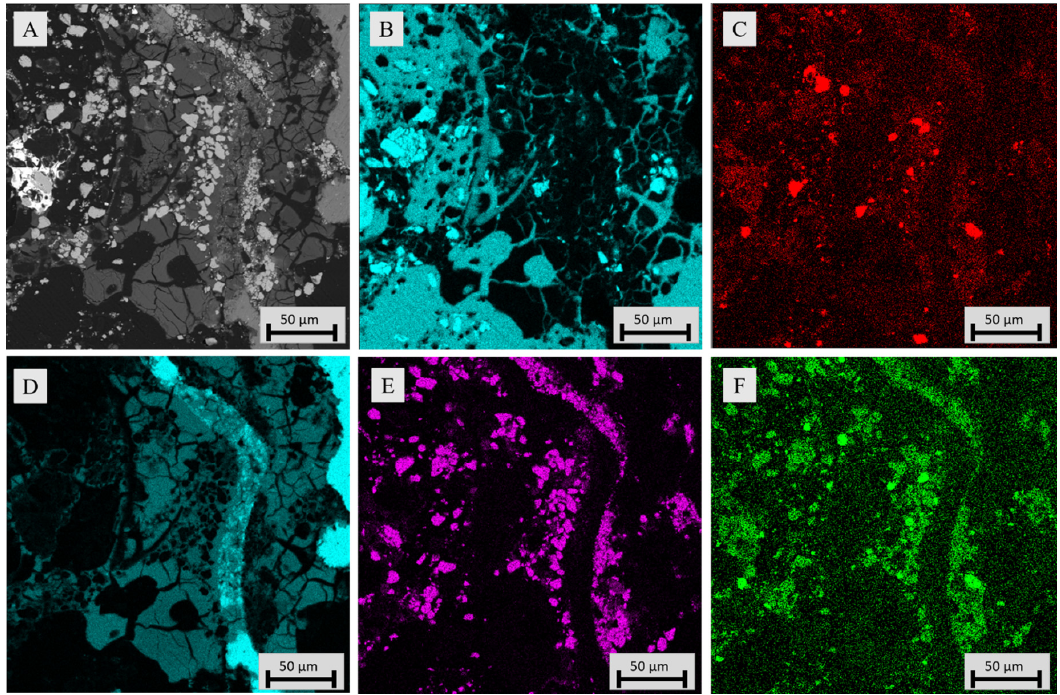
Figure 9. EDS-mapping of 0–1 min froth fraction, ( A ) overview, ( B ) carbon, ( C ) manganese, ( D ) aluminum, ( E ) cobalt, and ( F ) nickel.